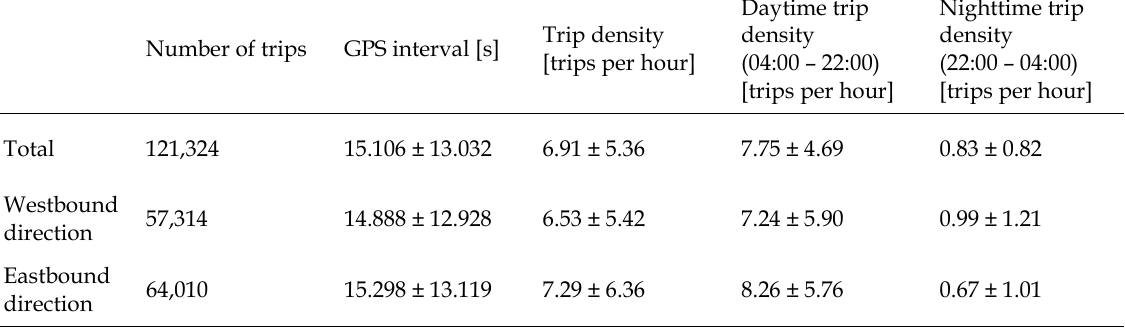
Parameter values of the FCD set (mean value and standard deviation)